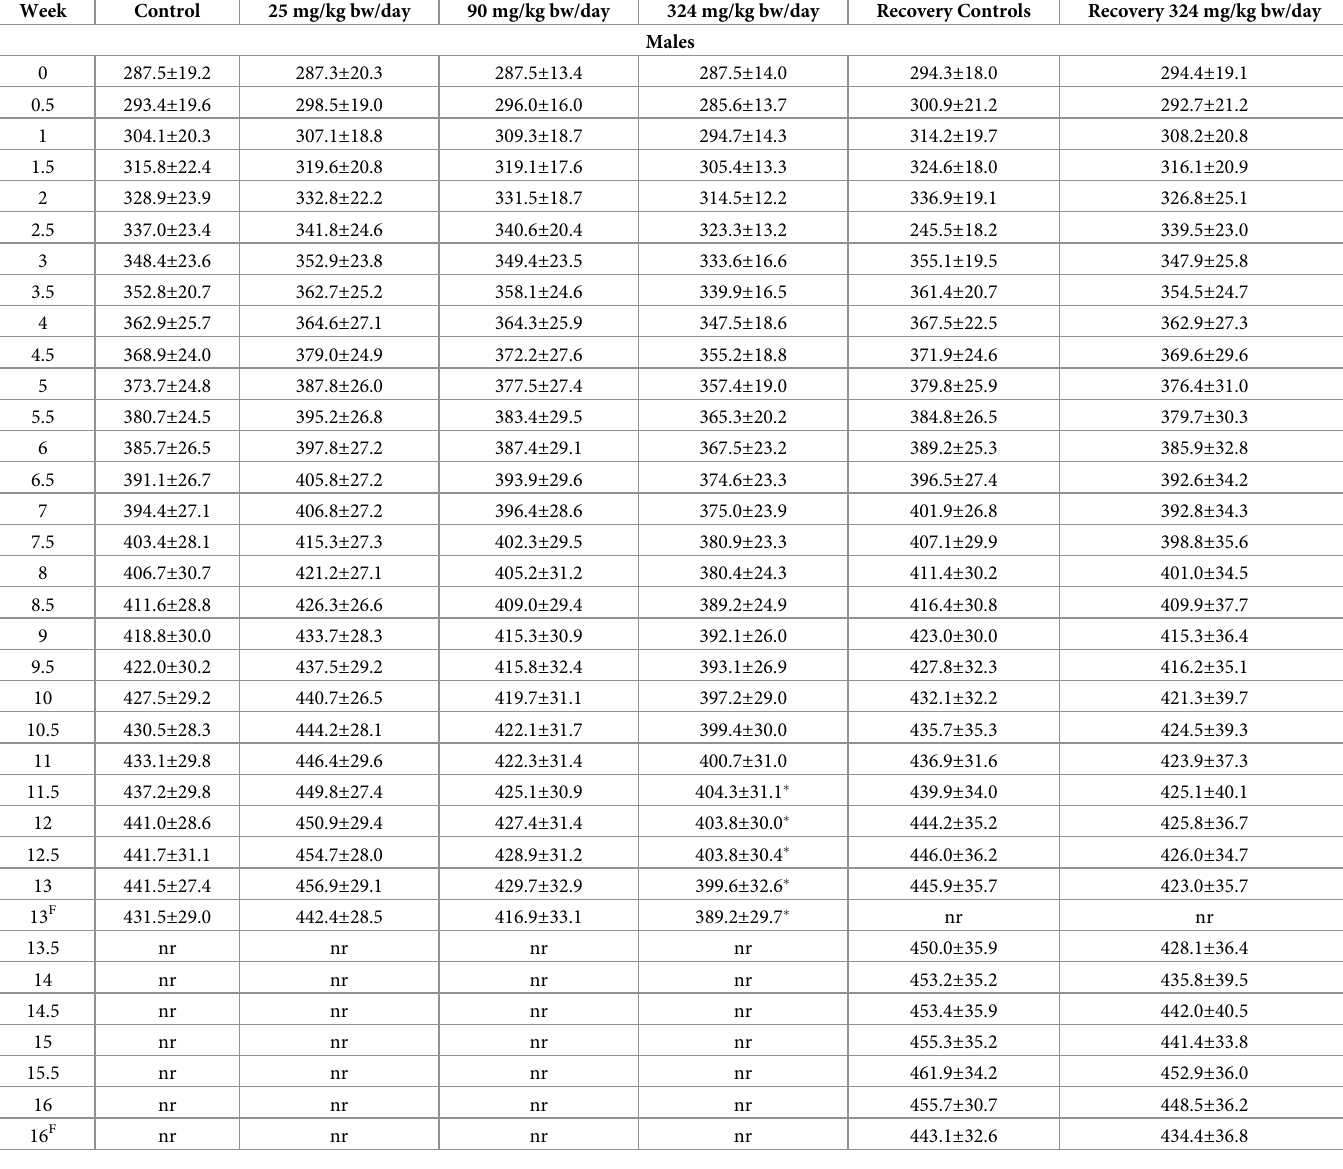
Table 1. Body weights for the 90-day study—Main and recovery